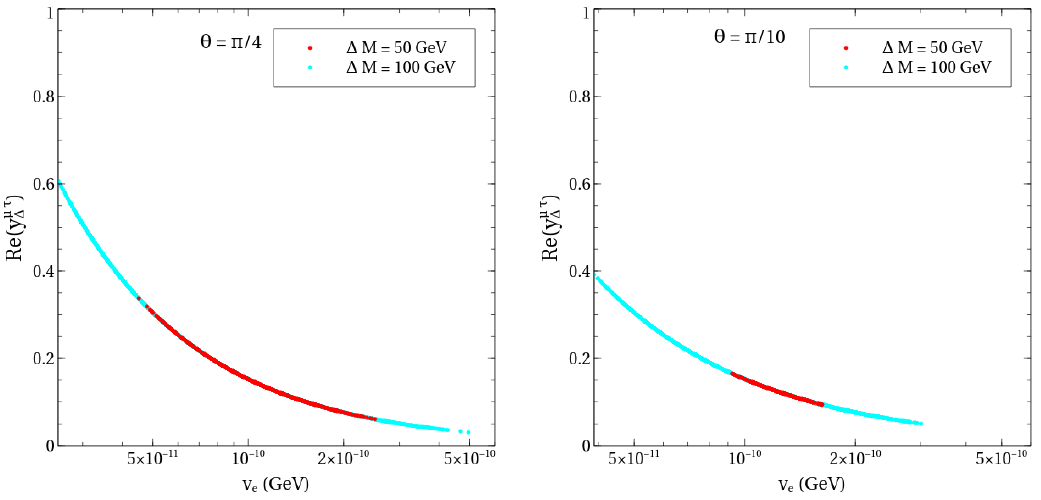
Figure 14 . Scatter points maintaining (cid:1) a (cid:22) within its 2 (cid:27) range and BR (cid:28) ! (cid:22) (cid:22)ee within the quoted limit in the v e Re( y (cid:22)(cid:28) ) plane for (cid:18) = (cid:25) (left) and (cid:25) (right). A normal neutrino mass hierarchy (cid:1) 4 10 (cid:0) is assumed. The color coding is explained in the legends.